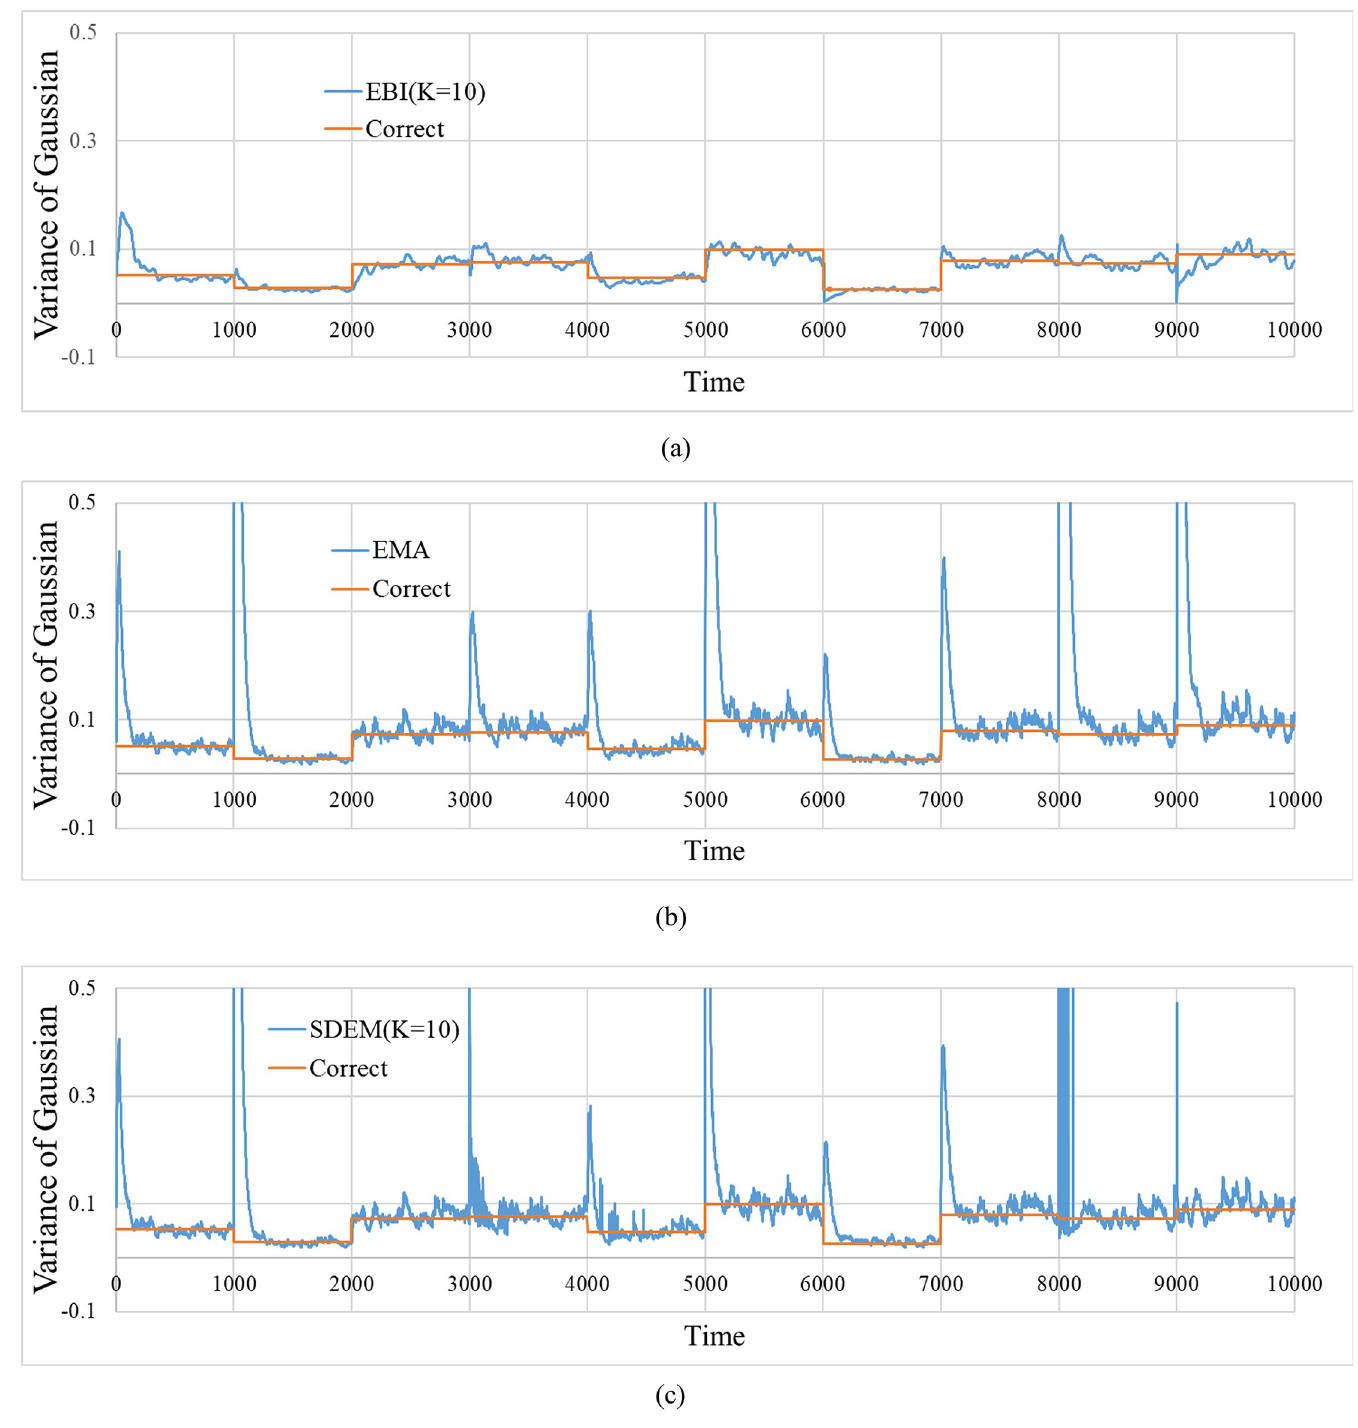
Fig 6. Time progress for the estimated values of the variance of the Gaussian. The figure includes the correct variance. (a) Estimated values by EBI. ( α , m , K ) = (0.03,0.0,10). (b) Estimated values by EMA. β = 0.03. (c) Estimated values by SDEM. ( β , K ) = (0.03,10).